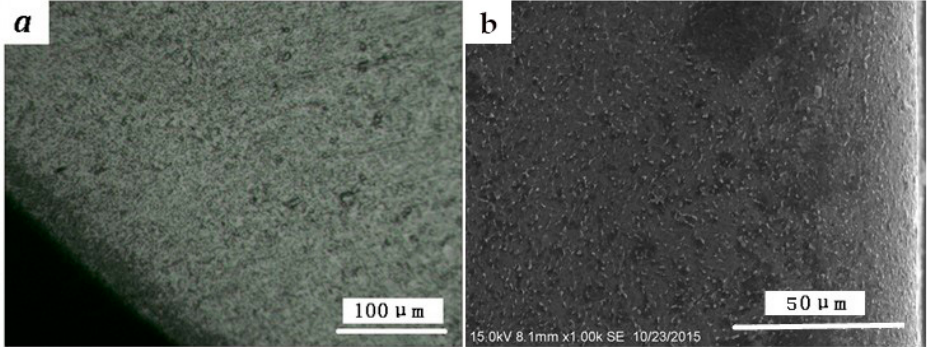
Figure 2. Microstructure and dissimilation surface layer of TC4 after ultrasonic nanocrystal